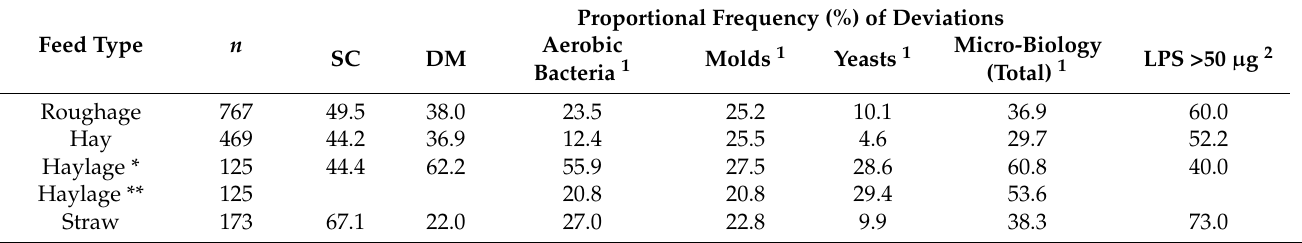
Table 4. Proportional frequency of deviations in the hygienic quality of hay, haylage, and straw samples concerning sensory control (SC), dry matter content (DM), counts of aerobic bacteria, molds, and yeasts, as well as microbiology in total and LPS